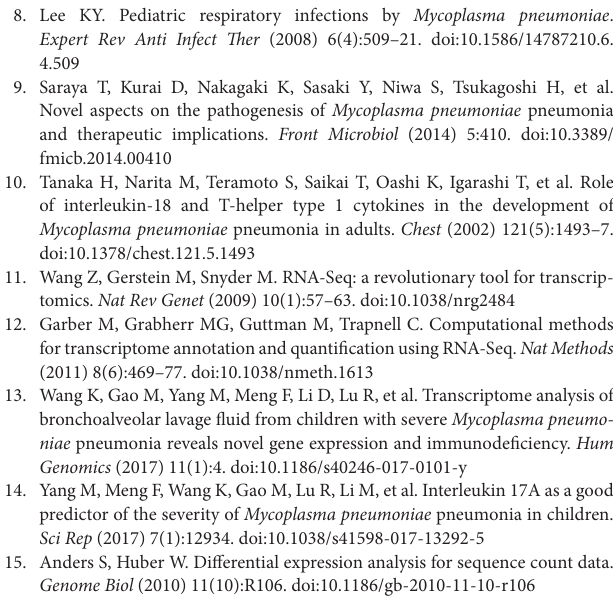
FigUre s1 | Protein interaction network analysis. The first neighbors of CD8A (a) , granzyme B (B) , and IFNG (c) were decided based on Search Tool for the Retrieval of Interacting Genes/Proteins database. The color of each dot reflects the log2 fold change of each gene, the red dots represent upregulated proteins, and the green dots represent downregulated protein. The proteins in big and blue font are associated with the specific Kyoto encyclopedia of genes and genomes pathways mentioned in Figures 3 – 5 . FigUre s2 | Other genes mapped to hematopoietic cell lineage Kyoto encyclopedia of genes and genomes pathway. Model diagram shows hematopoietic cell lineage pathway, which included the differentiation of mast cells, basophils, eosinophils, myeloid-related dendritic cells, macrophages, and neutrophils. The green squares represent genes that did not have significant differences between Mycoplasma pneumoniae pneumonia group and foreign body group. The white squares represent genes that were not